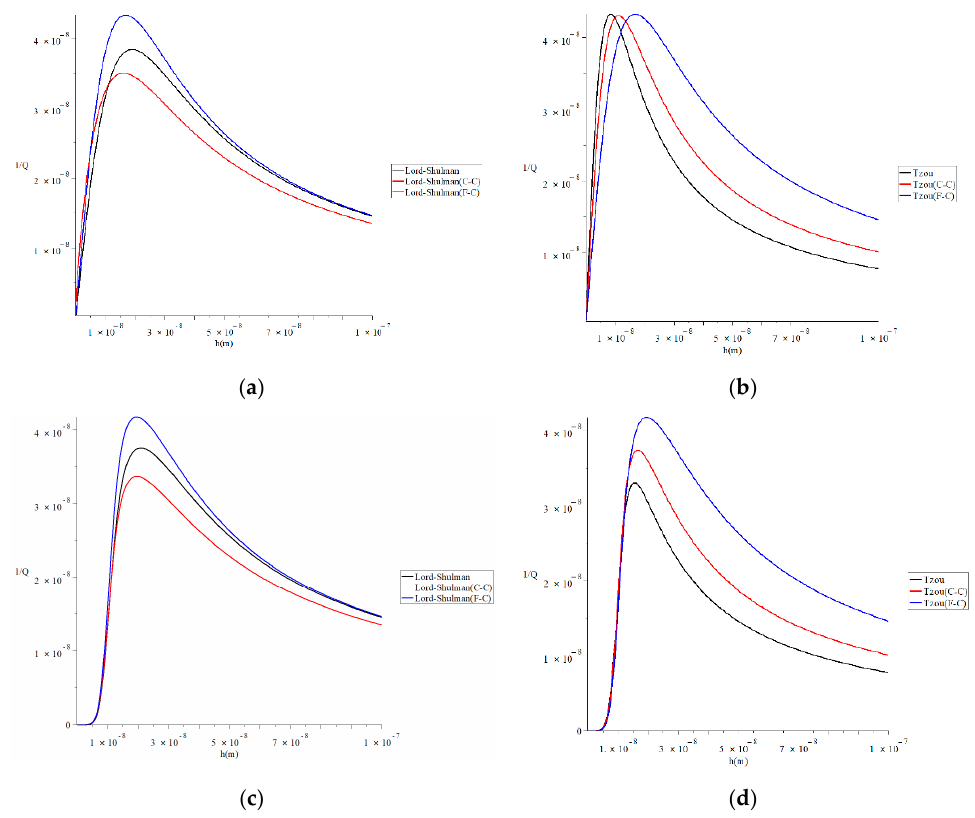
Figure 6. The thermal quality factor for different models with various values of the force due to static prestress when L = 50 h , b = 4 h , q = 4.73/ L , and β = 0.6. ( a ) The thermal quality factor for the Lord–Shulman model when F = 0.0 N ; ( b ) the thermal quality factor for the Tzou model when F = 0.0 N ; ( c ) the thermal quality factor for the Lord-Shulman model when F = 10 − 40 N ; ( d ) the thermal quality factor for the Tzou model when F = 10 − 40 N.